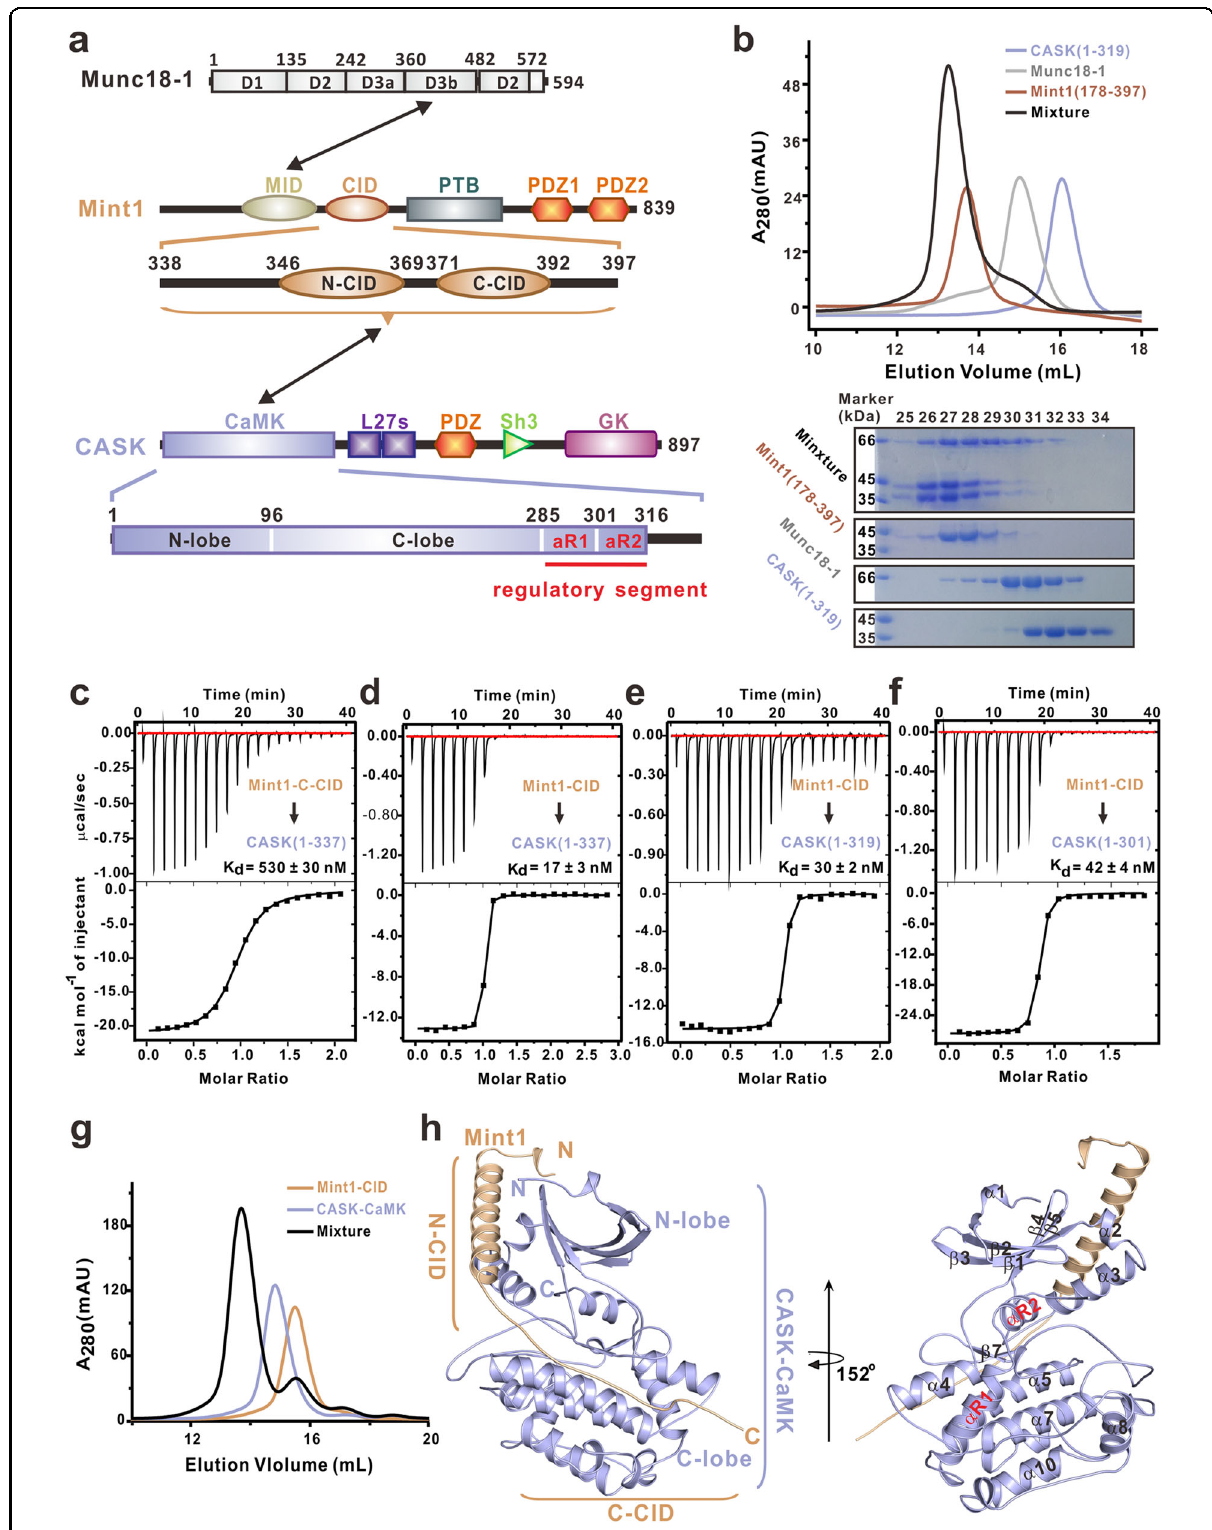
Fig. 4 (See legend on next